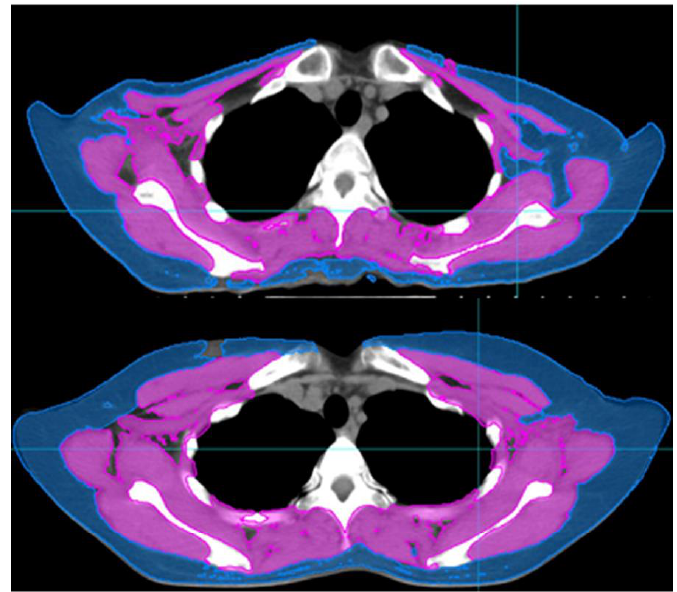
Figure 1. Computed tomography images of patients with skeletal muscle loss ( upper ) and without skeletal muscle loss ( lower ). skeletal muscle index of upper image: 4.88, skeletal muscle index of lower image: 9.83